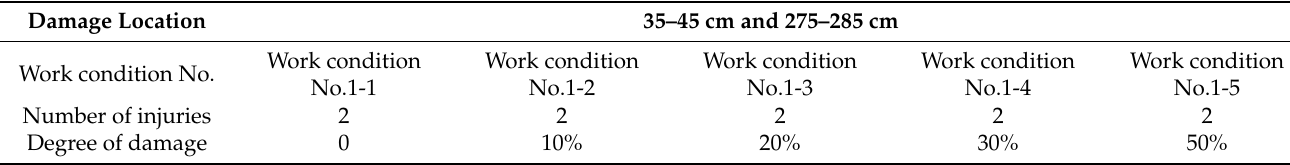
Figure 8. Diagram of work condition Model 2. Table 1. Damage information of Condition 1. Table 2. Work condition 2 damage information.